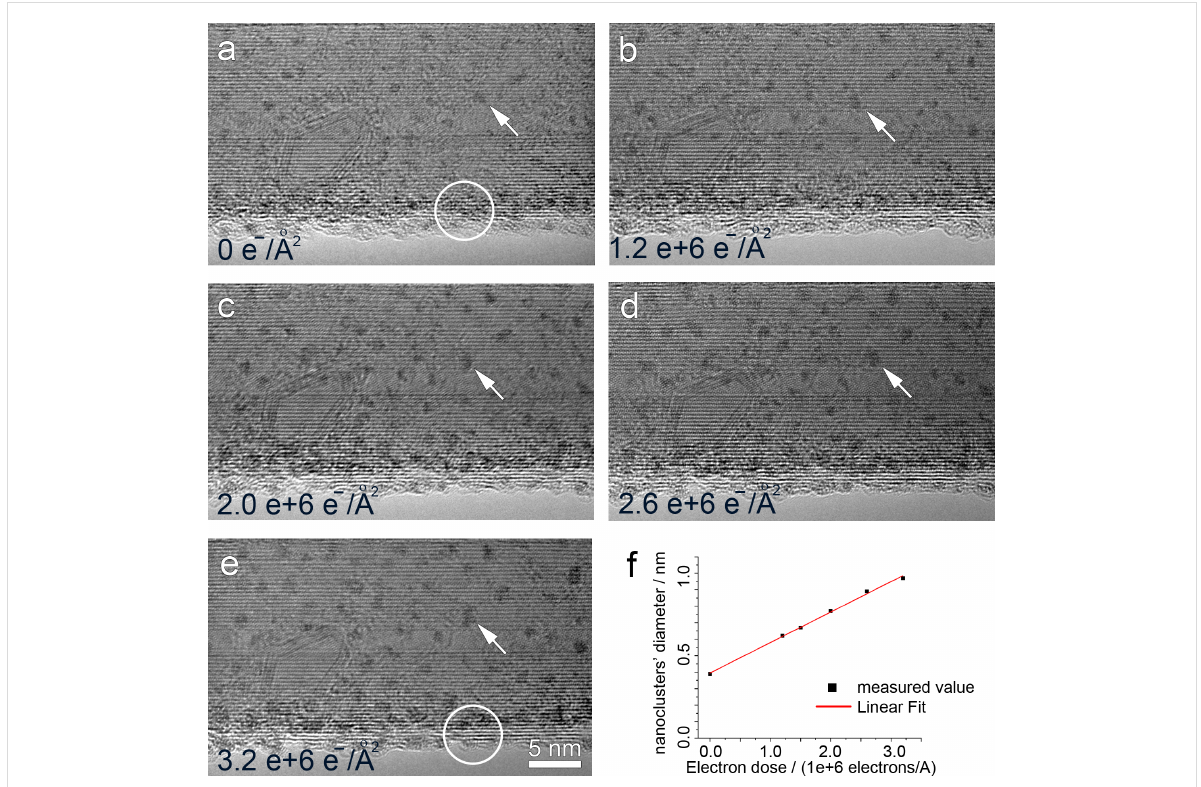
Figure 7: HRTEM images showing that amorphous carbon can be reduced by in-situ electron irradiation in a TEM under 80 kV. (a) shows the FEBID on CNT before electron irradiation. (b–e) show that the amorphous carbon is gradually cleaned by increasing the dose of electrons. Comparing the circled area indicated in (a) and (e), the cleaning of amorphous carbon is obvious. (a–e) also show the growing of nanoclusters by increasing electron dose, one example is indicated by an arrow through the image series. The growth of nanoclusters is quantified as shown in (f), with the diameter of nanoclusters increasing linearly by electron